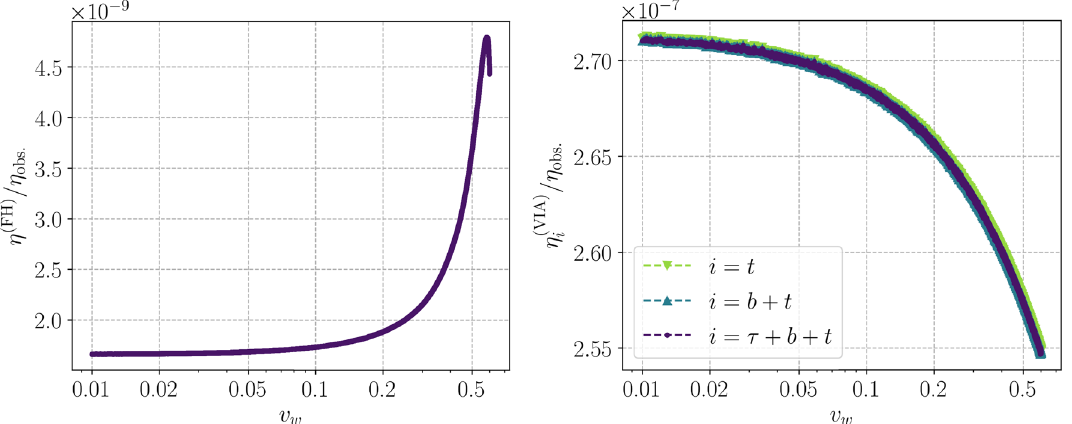
Fig. 4 BMPI : BAU normalised to the observed value obtained in the FH approach (left) and in the VIA approach (right) as function of the wall velocity v W . Results are shown in the VIA approach for the inclusion of the t , b and τ contributions (violet points), of the t and b contributions (blue triangles), and of the t contributions only (green triangles)